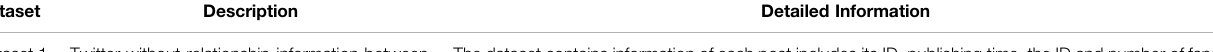
Dataset 1 Twitter without relationship information between users Dataset 2 Twitter with relationship information between